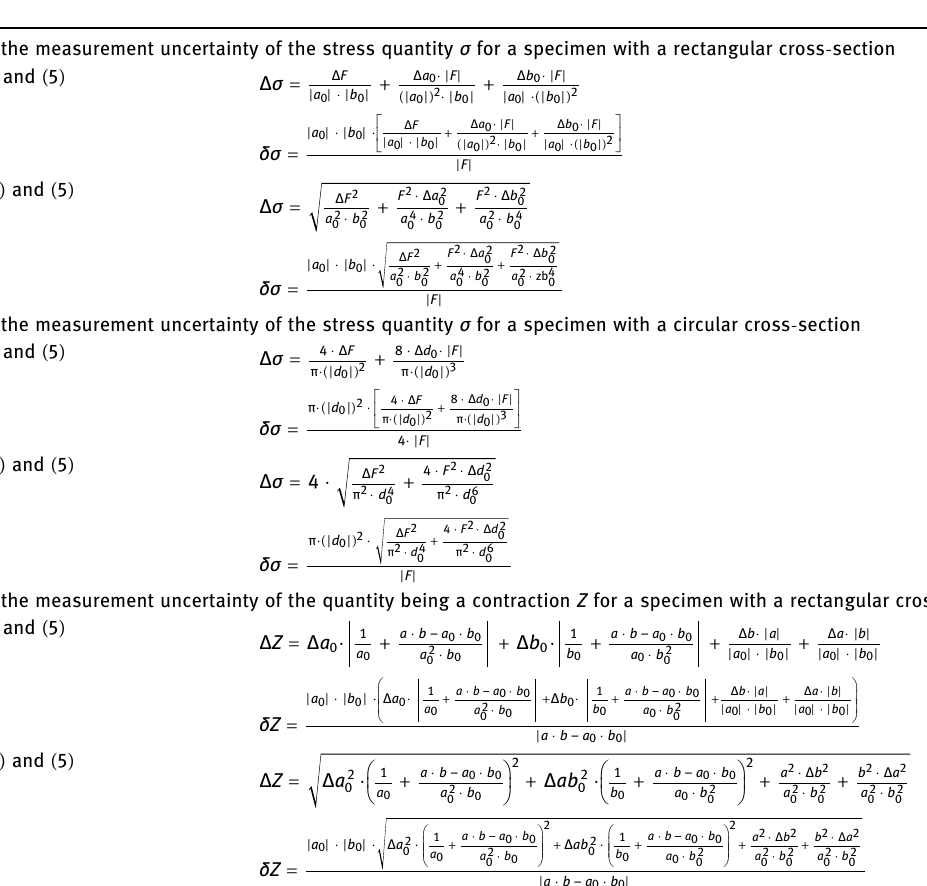
Equations ( 9 ) and ( 5 )